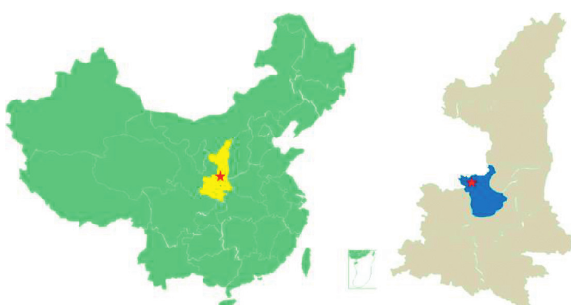
Figure 1: Location plan of Baizi Coal Mine.